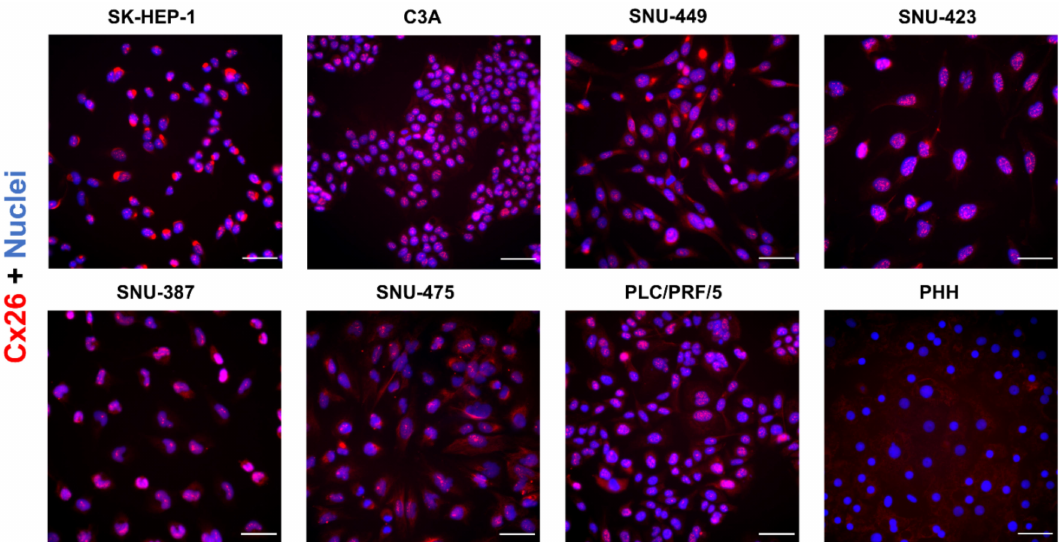
Figure 4. Cx26 protein localization in liver cancer cell lines and primary human hepatocytes (PHH). Cancer cell lines ( n = 1, N = 2) were fixed during the exponential growth phase, while PHH were fixed at the final day of the sandwich cultivation period. All cells were immunostained for Cx26 (red) with nuclear counterstaining using 4 (cid:48) ,6-diamidino-2-phenylindole (DAPI) (blue). Scale bar = 50 µ m. Images were taken with a 40 × objective. A representative image is